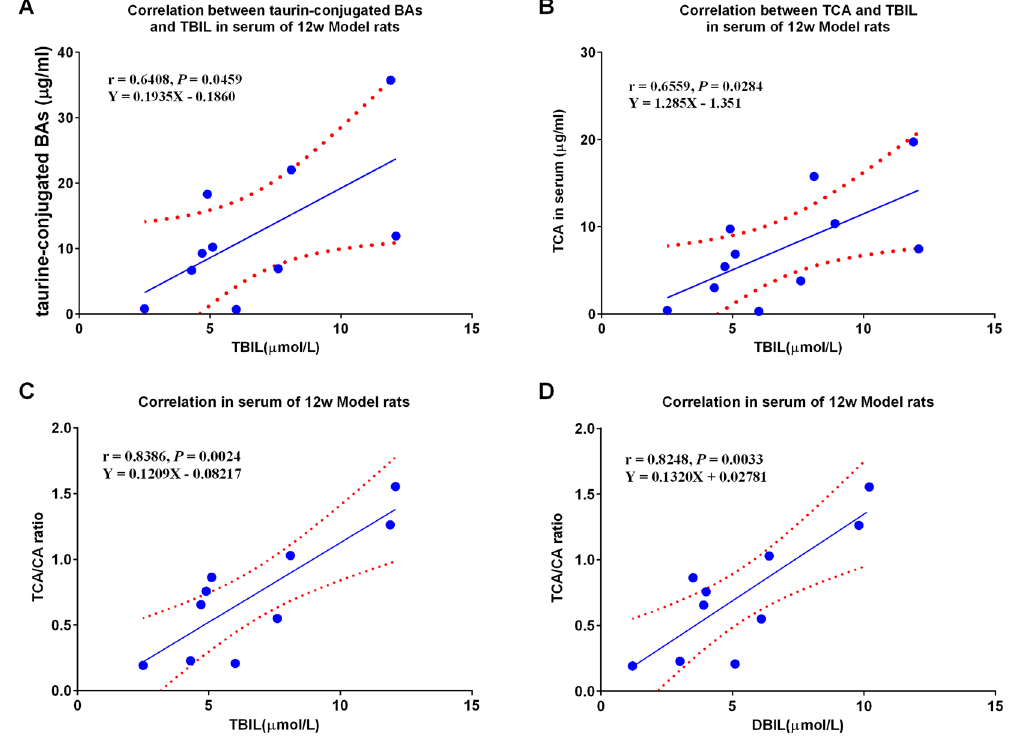
Figure 7. Correlation analysis between serum BAs and bilirubin. ( A ) taurine-conjugated BAs vs . TBIL; ( B ) TCA vs . TBIL; ( C ) ratio of TCA to CA vs . TBIL; and ( D ) TCA/CA vs .